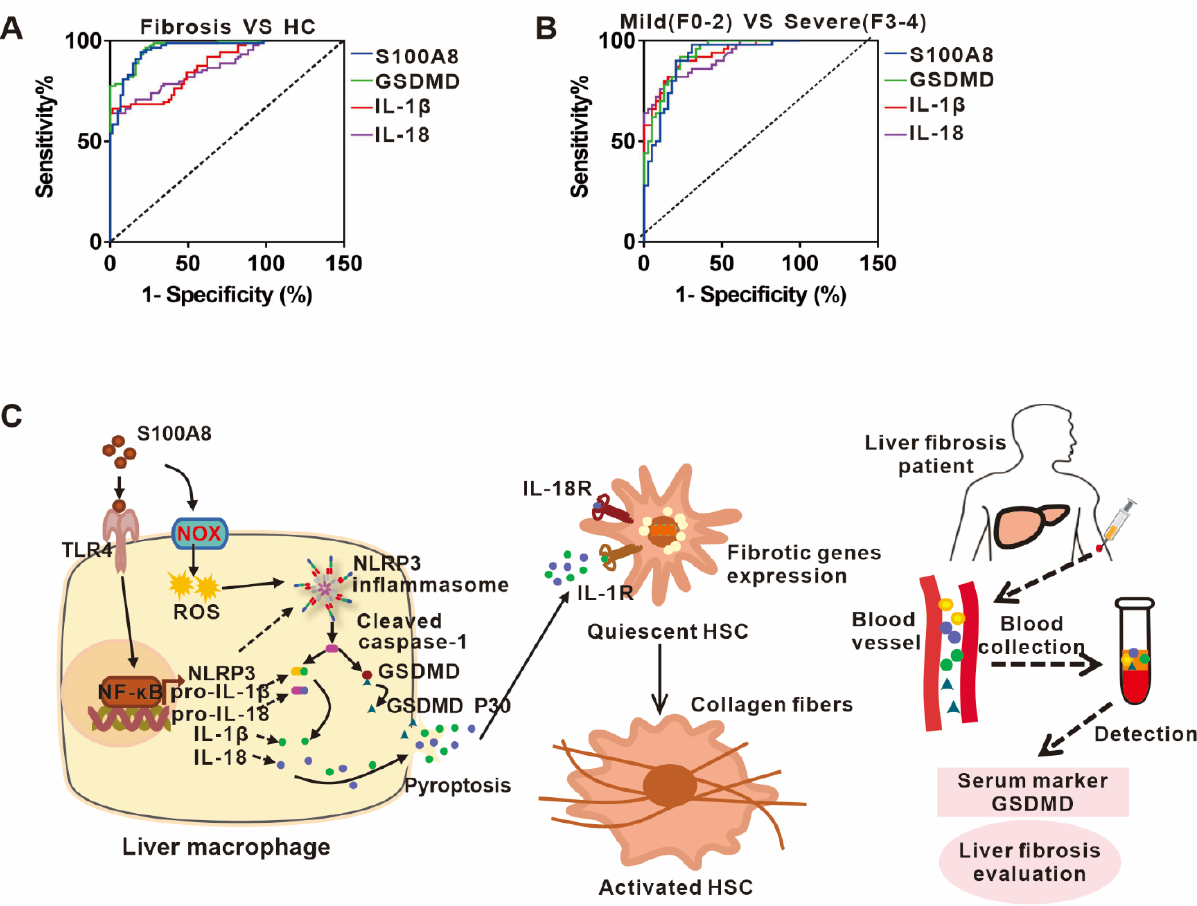
Figure 6. The potential predictive powers of S100A8, GSDMD, IL-1 β , and IL-18 for the occurrence and severity of liver fibrosis. ( A ) ROC curves of serum S100A8, GSDMD, IL-1 β , and IL-18